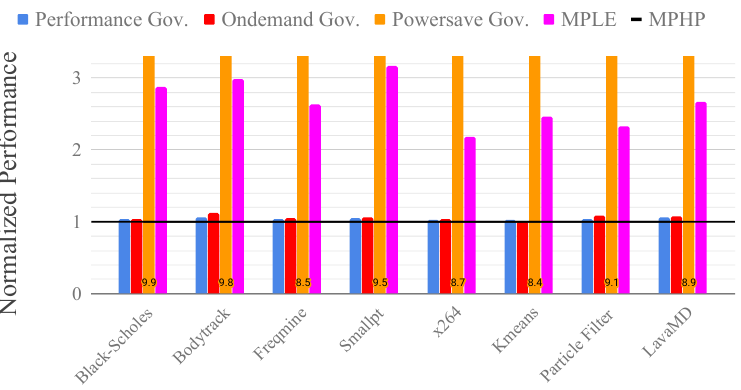
Figure 6. Normalized energy consumption by the measured Pareto configuration that provides the least energy consumption (MPLE) for each application.